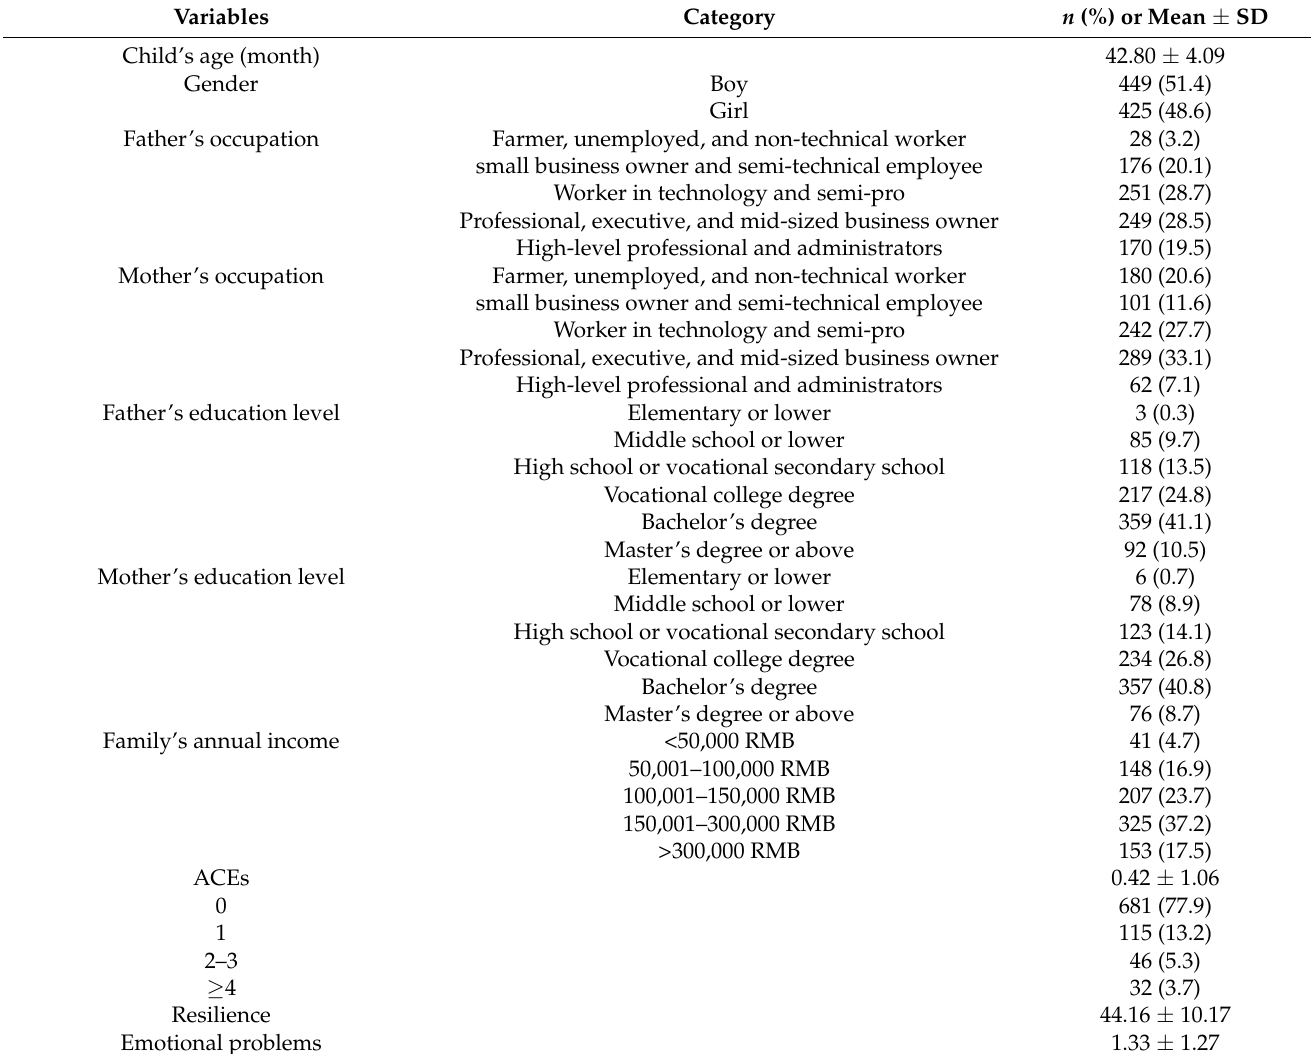
Table 1. Descriptive information for all studying